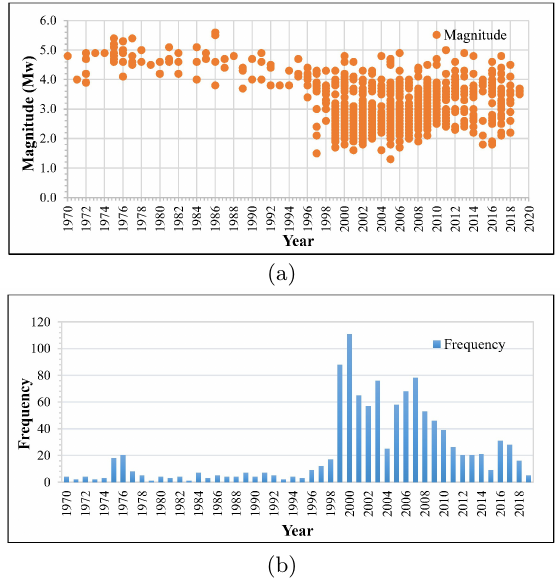
Figure 4. (a) Magnitude and (b) Frequency distribution of earthquakes for the periods 1970-2018 occurred within 50km radius of the Kotrupi landslide Nearly 55% of the earthquakes which have occurred within 50 km radius of study area, are shallow earthquake with focal depth of 10-20 km as given in Table-1. Shallow